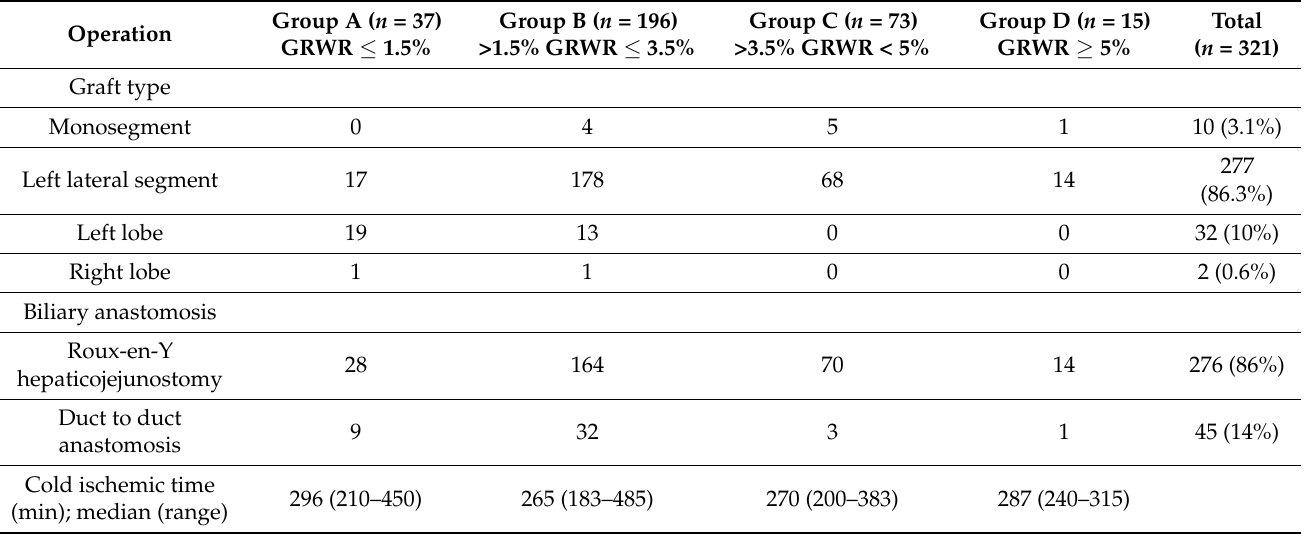
Table 4. Surgical